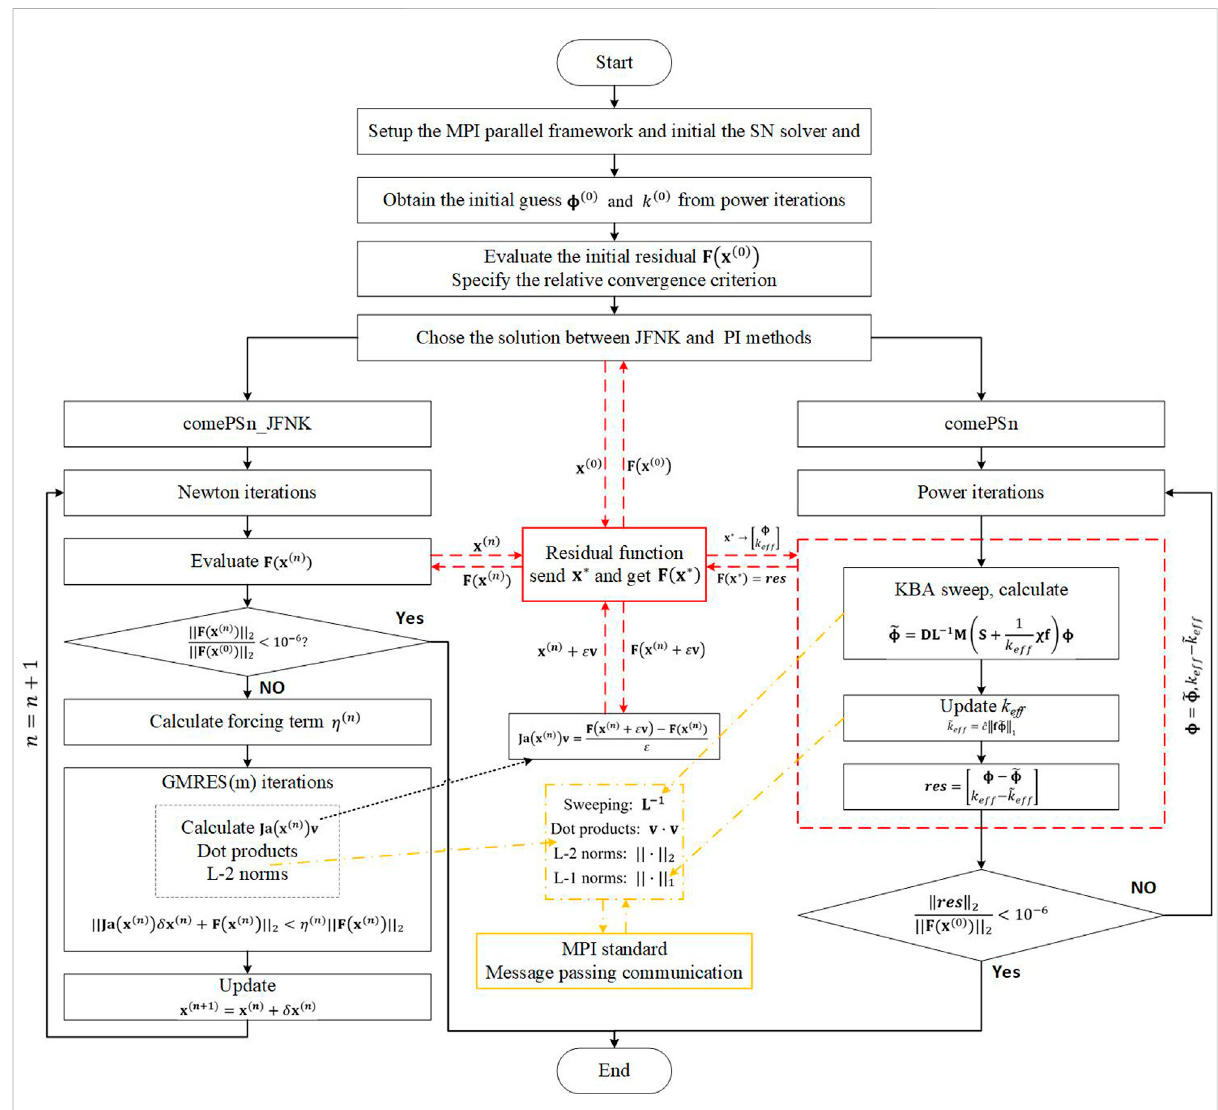
FIGURE 1 Iterative strategies and fl owchart for the comePSn_JFNK and comePSn